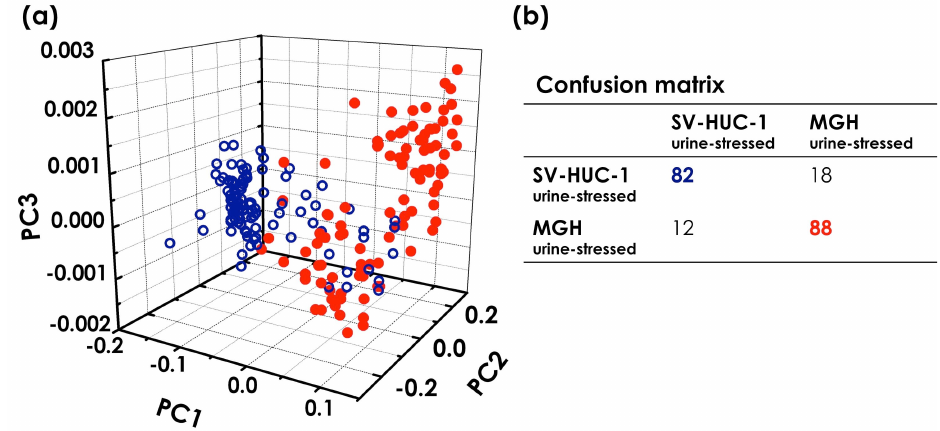
Figure 8. ( a ) 3D PCA score plot of modulated Raman spectra for 100 urine-stressed normal (blue circle) and 100 urine-stressed bladder cancer cells (red dot); ( b ) confusion